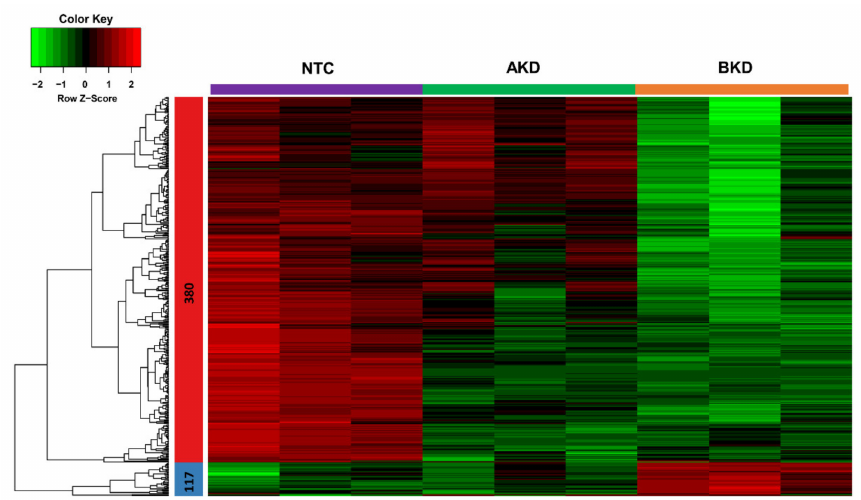
Figure 1. Heatmap of mRNAs expression profiles in non-targeting control (NTC), LIN28A knock- down (AKD), and LIN28B knockdown (BKD) trophectoderm (TE). Each column represents the expression profile of genes in a single day 16 TE. A total of 497 genes were distributed in two clusters based on their co-expression with cut-off criteria of FPKM ≥ 5, |logFC ≥ 5|. In the color key, the red color represents upregulation, the green color represents downregulation, and the black color represents no change in expression.